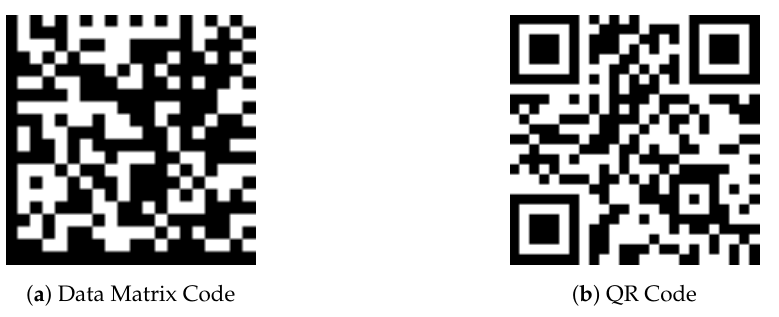
Figure 6. The 32-character hexadecimal value, rendered as two-dimensional bar code